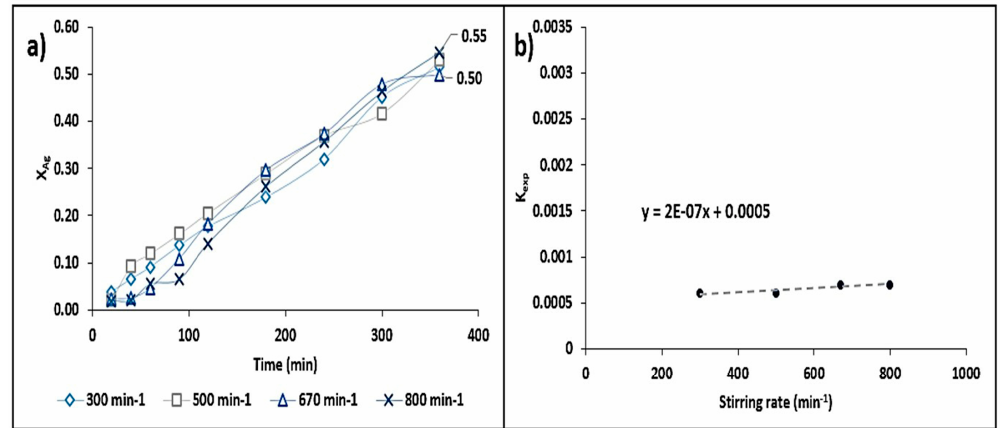
Figure 11. ( a ) Graphical representation of the stirring rate evaluation, RPM = 300, 500, 670 and 800 min − 1 , V = 0.5 L, Mineral = 40 g · L − 1 , P O2 = 1 atm, pH = 9.0, t r = 360 min, d = 74 µ m, [S 2 O 32 − ] = 0.5 mol · L − 1 , [OH − ] = 0.1 mol · L − 1 , 298 K. ( b ) Dependence of k exp in function of the stirring rate.